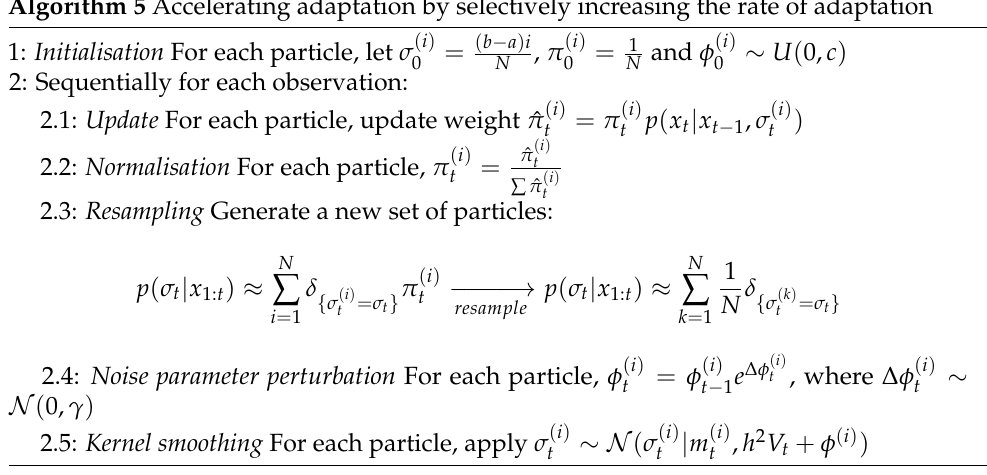
; ( ii ) 2.0 ; ( iii ) 20.0 ; ( iv ) 200.0 N N N N